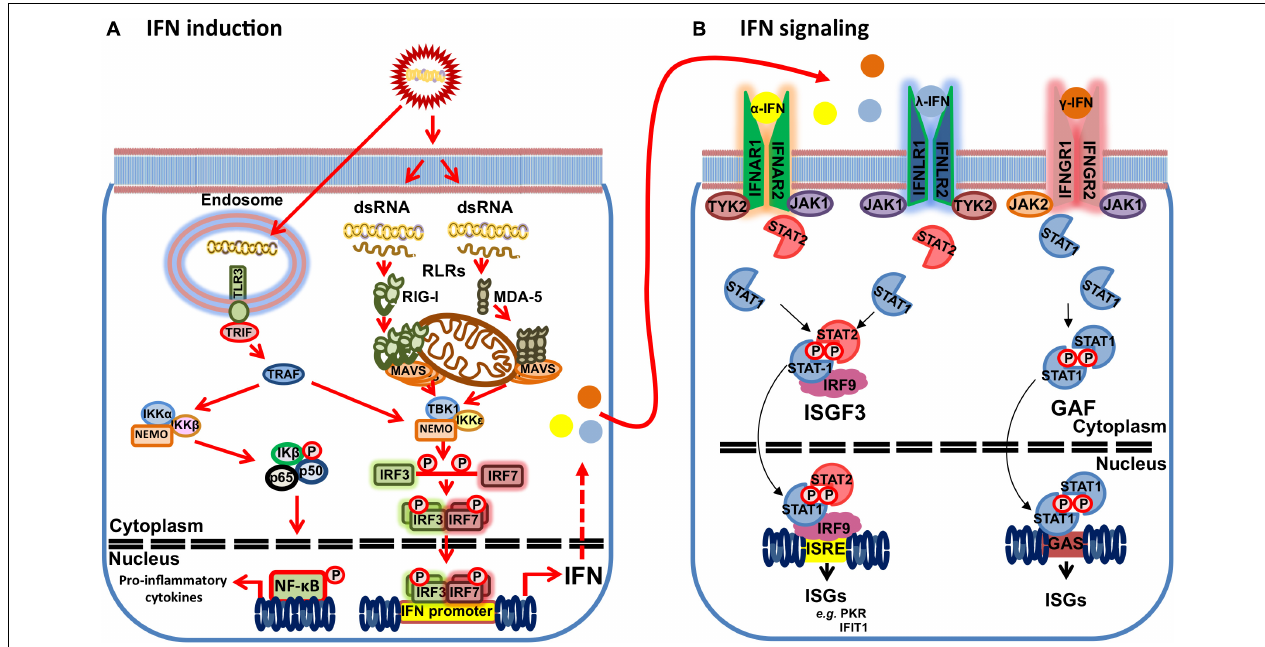
FIGURE 1 | Schematic of the IFN response to dsRNA viruses. (A) dsRNA motifs can be recognized by retinoic acid-inducible gene-I (RIG-I) like receptors (RLRs) (RIG-I and MDA-5) in the cytoplasm or Toll-like receptor (TLR) 3 in the endosomes that trigger IFN and proinflammatory cytokine production. Activated RLR are recruited to mitochondrial antiviral signaling (MAVS) protein, which in turn recruit tumor necrosis factor receptor-associated factors (TRAF). TLR3 signals through its adaptor protein Toll/IL-1R domain-containing adaptor inducing IFN- β (TRIF) to activate TRAFs. TRAFs promote the activation of the TANK binding kinase 1 (TBK1) complex [composed of TBK1, I κ B kinase ε (IKK ε ) and NF- κ B essential modulator (NEMO)] leading to TBK1 activation that mediates phosphorylation and homodimerization of the IFN regulatory factors (IRF) 3/7. Activated IRF3/7 dimers translocate to the nucleus to trigger IFN gene transcription. TRAF activation also promote the activation of the IKK complex (composed of IKK α and β , and NEMO) that activates NF- κ B and the transcription of pro-inflammatory cytokines. (B) IFNs signals through their heterodimeric surface receptors (IFNAR1 and 2 for α -IFN; IFNLR 1 and 2 for λ -IFN; and IFNGR 1 and 2 for γ -IFN) that lead to activation of intracellular Janus Kinase (JAK)/signal transducer and activator of transcription (STAT) pathways and to the transcription of IFN-stimulated genes (ISGs). Binding of α -IFN to its receptor activates the JAK kinases JAK1 and TYK2, which in turn leads to the phosphorylation of STAT1 and STAT2. Phosphorylated STAT1 and STAT2 dimerizes and binds to IRF9 to form the transcriptional factor complex IFN stimulated gene factor (ISGF) 3 that translocates to the nucleus to bind the IFN-response elements (ISRE) in ISG promoters and drive the expression of ISG products, such as protein kinase R (PKR) or interferon-induced proteins with tetratricopeptide repeats (IFIT) 1. λ -IFN signaling follows this same canonical pathway as α -IFN signaling. γ -IFN signals through its receptor by activating the JAK kinases JAK1 and JAK2 that leads to STAT1 phosphorylation and homodimerization into the transcription factor termed the gamma interferon-activated factor (GAF). GAF then binds gamma interferon-activated site (GAS) to drive the transcription of ISGs dependent on γ